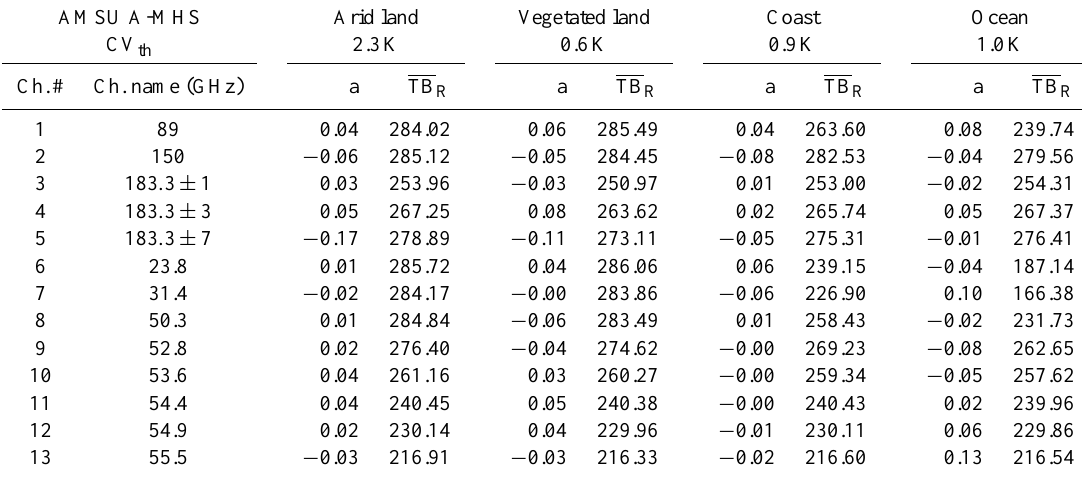
Table A3. List of CCA coefficient and CVth threshold used by the CCA algorithms for the AMSU/MHS data